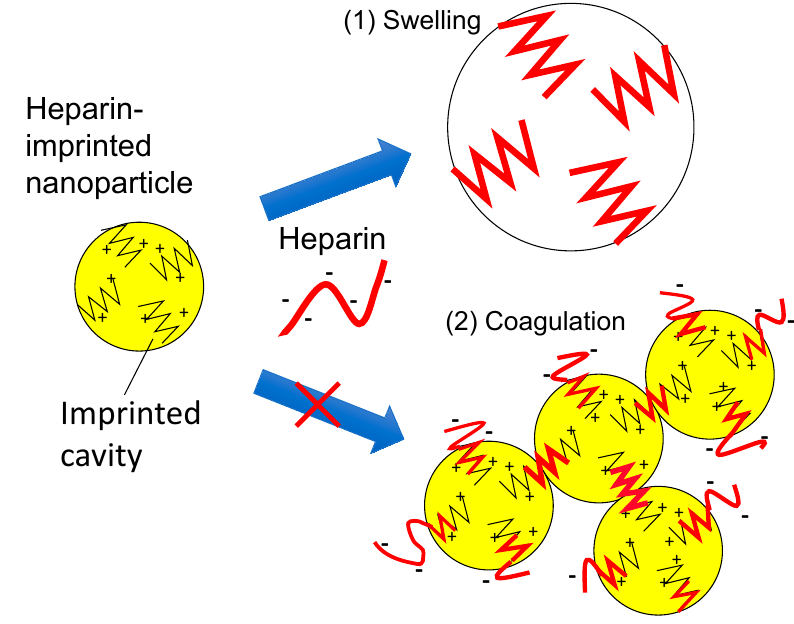
Figure 5. Scheme of hypothetical mechanisms for the size increase of the heparin-imprinted nanoparticles by specific interaction with the template.